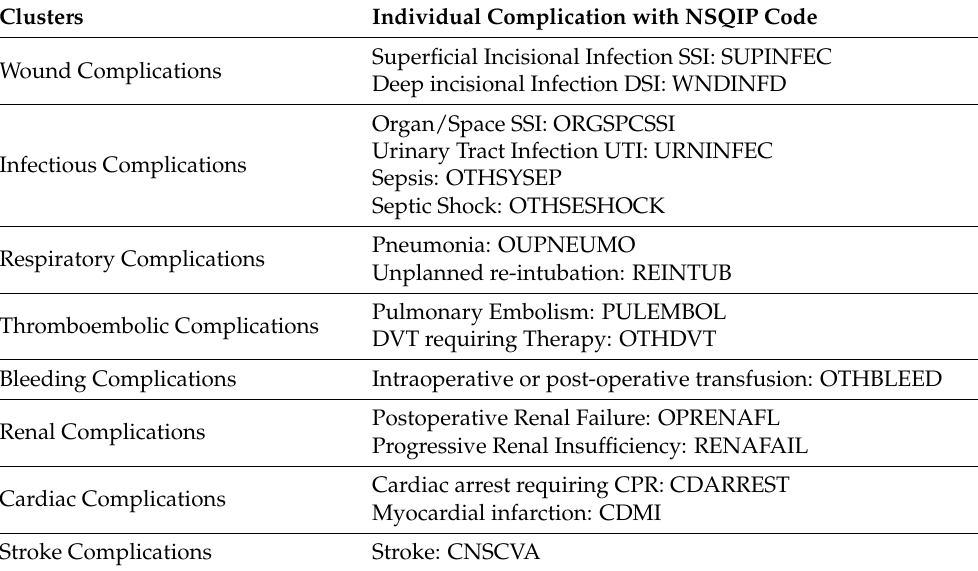
Table 1. Complication Clustered from NSQIP database.